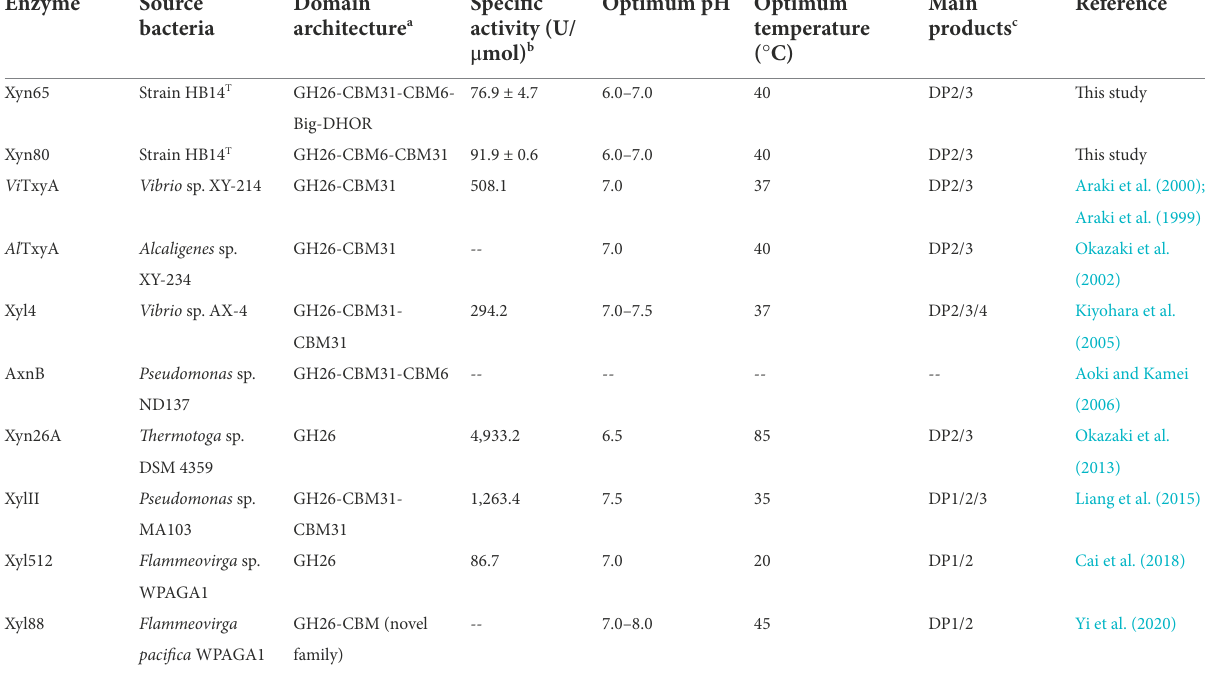
TABLE 3 Characteristics of Xyn65, Xyn80 and reported 1,3-xylanases.